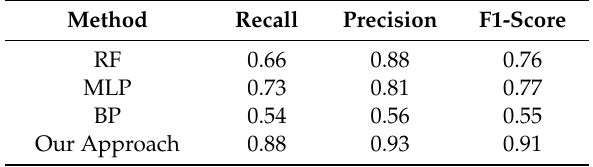
Table 2. Classification results of classical machine learning methods.